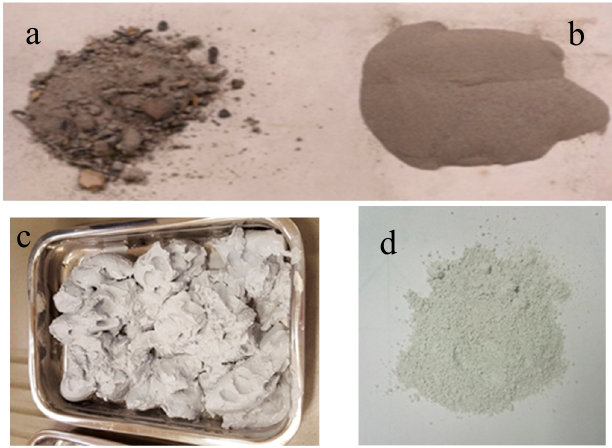
Figure 1. Pictures of raw materials ( a ) raw wood bottom ash (WBA); ( b ) WBA after sieving; ( c ) GeoSilex (G) paste; and ( d ) G powder.